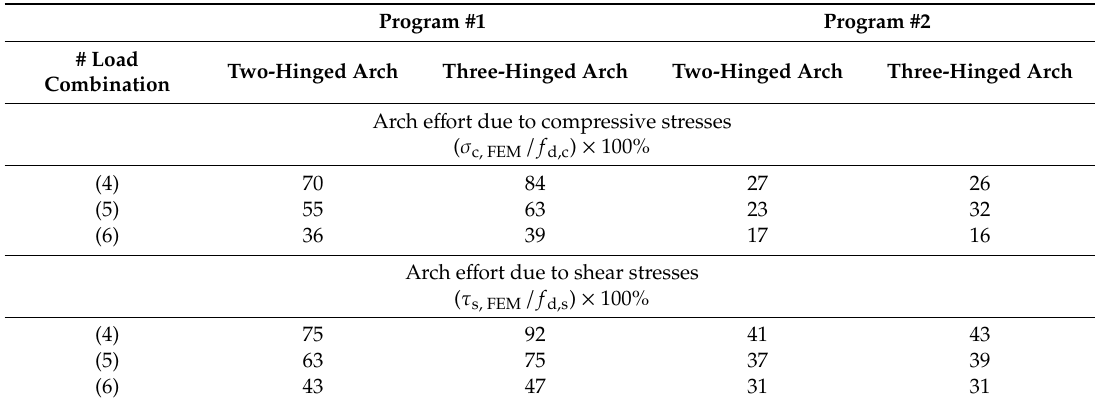
Table 5. Masonry arch safety for the applied load combinations and models